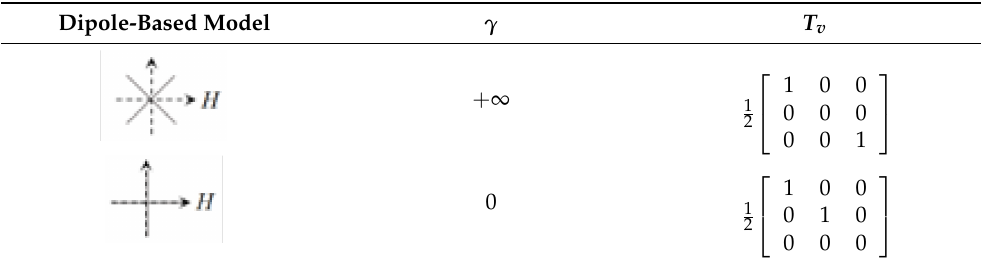
Table 1. The structure and coherency matrix of the dipole-based model corresponding to the mini- mum and maximum value of γ